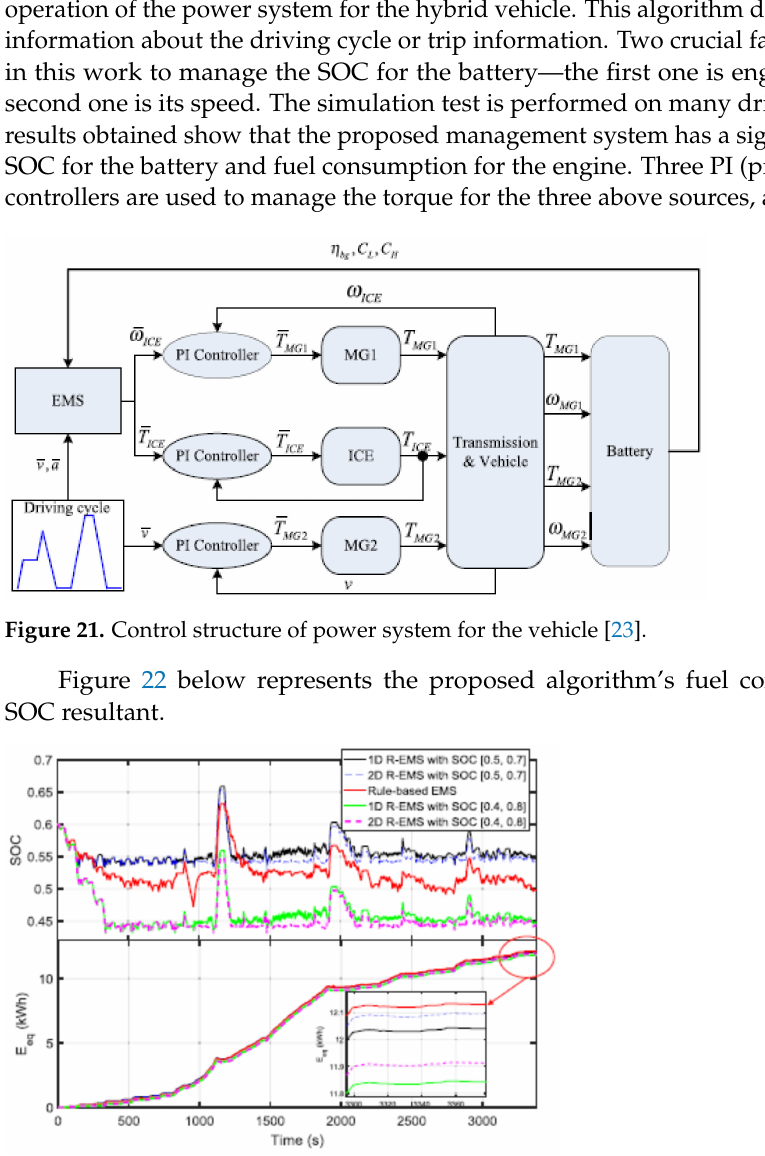
Figure 22. Simulation results for the SOC and fuel consumption (E eq ) using the proposed algorithm